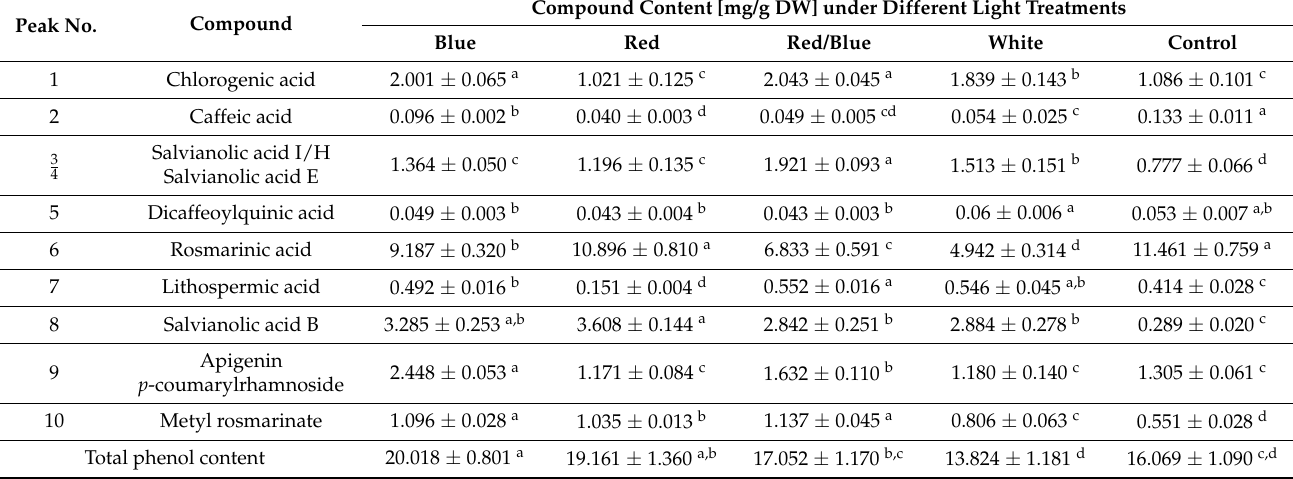
Table 1. The effect of light conditions: blue, red, blue/red, white, fluorescent on accumulation of phenolic compounds in D. forrestii shoot culture. The values represented means ± SE of three independent experimental replicates. Peak